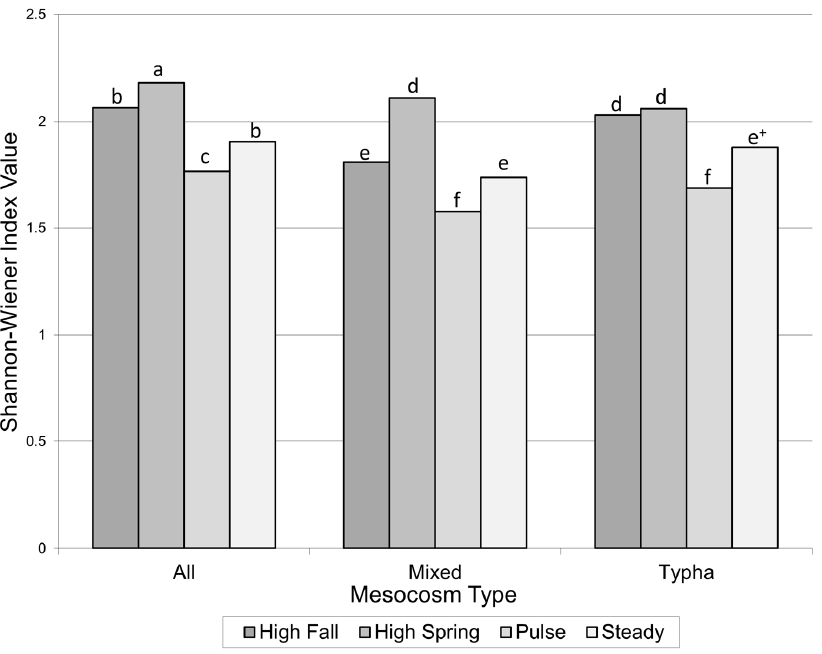
Figure 3. Shannon–Wiener macroinvertebrate diversity indices for aggregated data for vegetation and hydrology treatment types, using Hutcheson t-tests (significant differences a > b, b > c, d > e, f; + d-e = n.s. within Typha mesocosms).